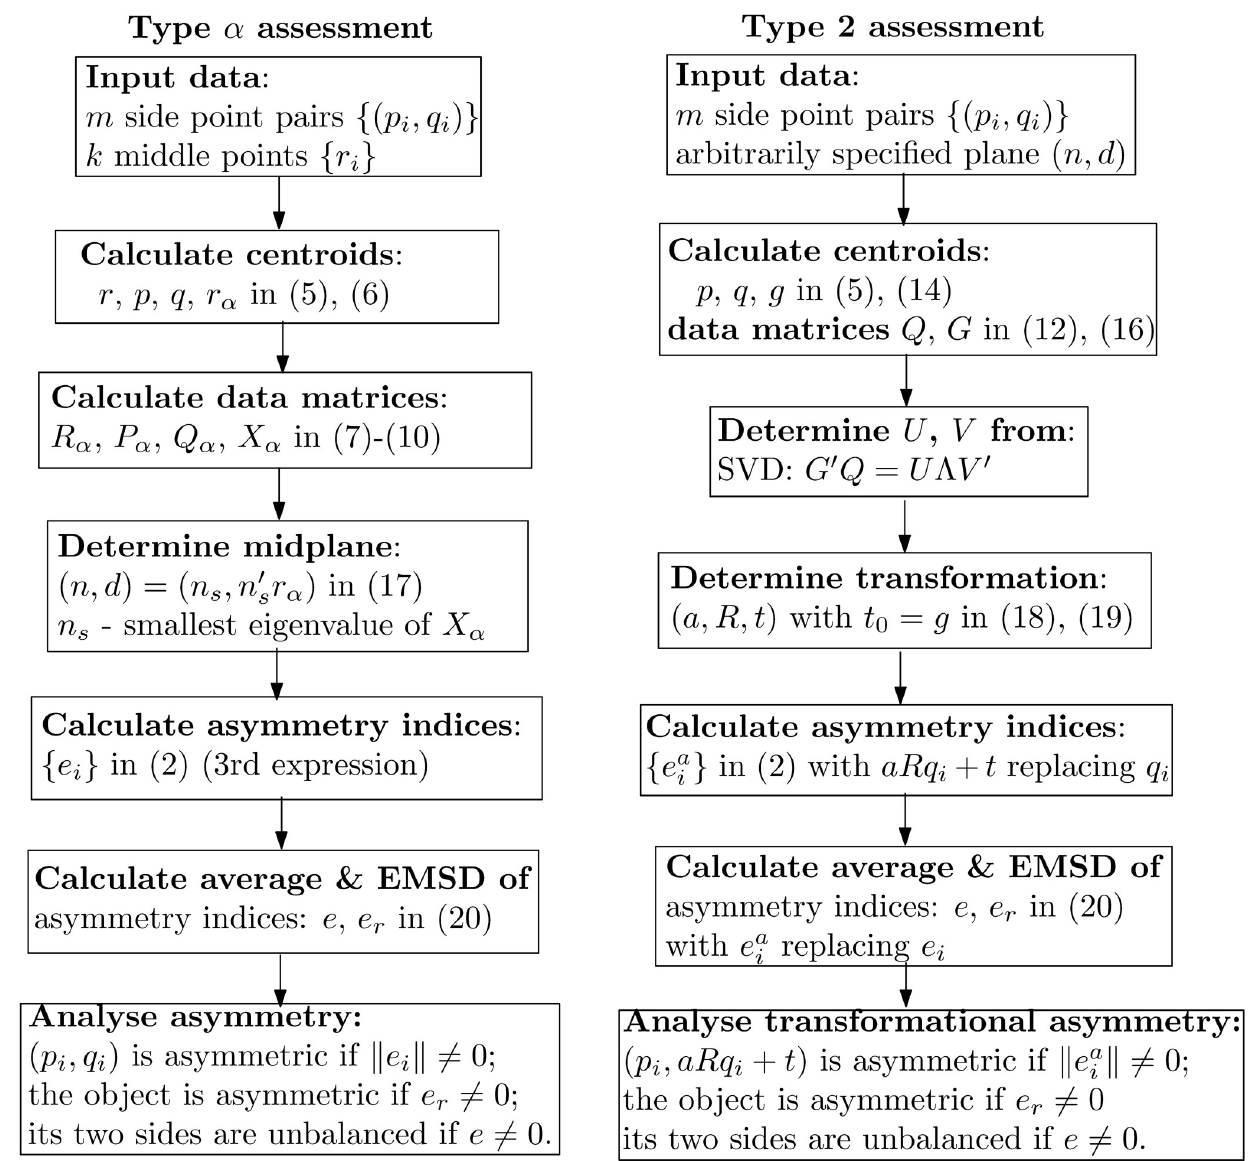
Fig 2. Flowcharts of plane asymmetry assessments of types α and 2 at individual